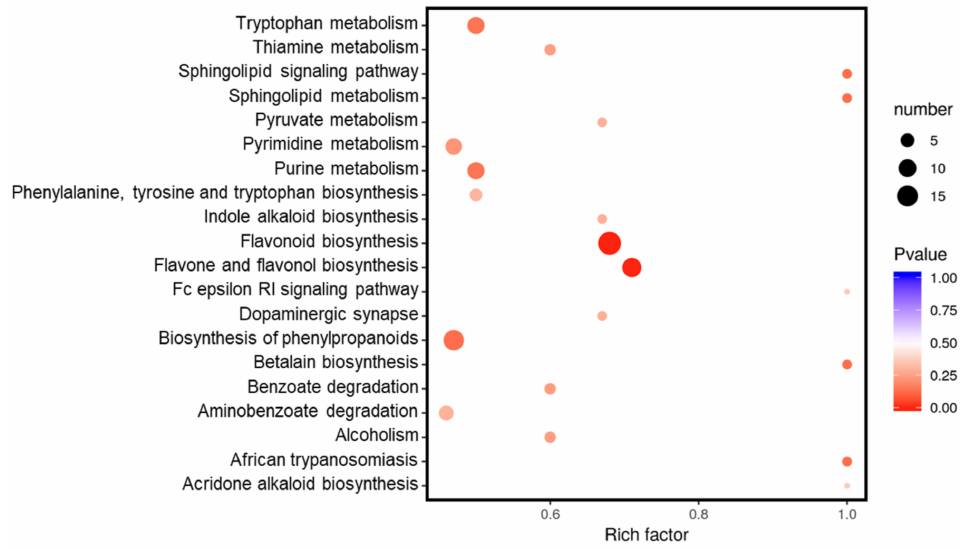
Figure 4. KEGG pathway enrichment of all differentially accumulated metabolites in RG vs. SG13 leaves. The 20 most significant catalogues with lowest corrected p -value are